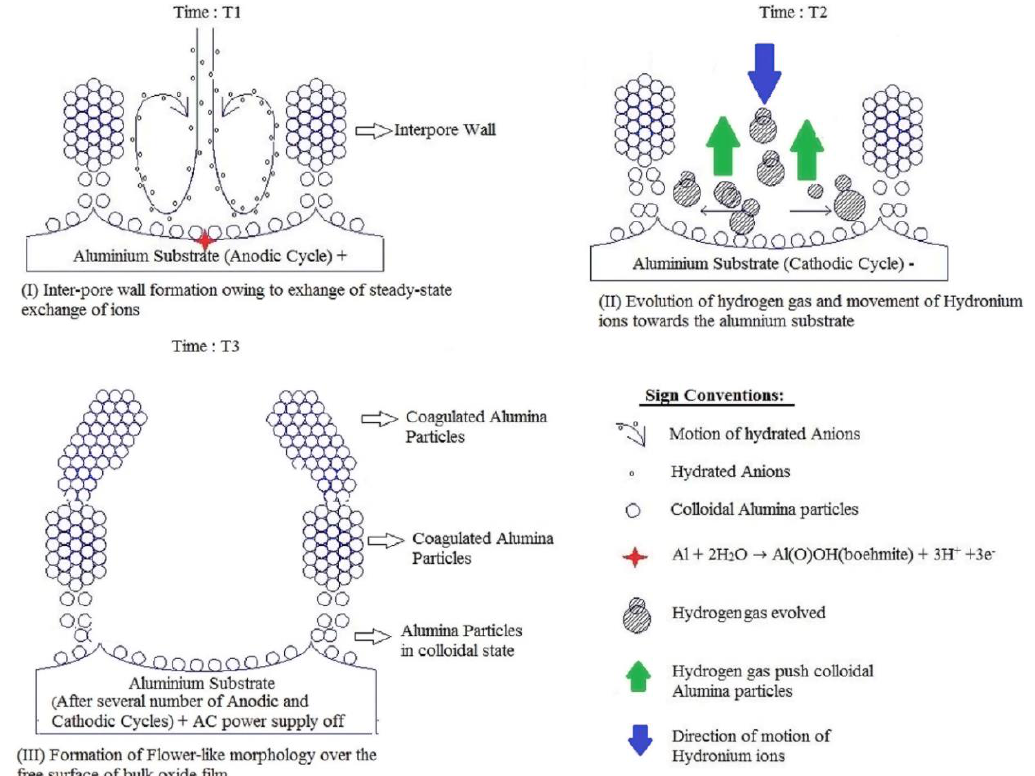
Figure 27. An extended model proposed by Chelliah et al. (based on the existing theory of electroconvection-assisted PAA formation) in order to include consideration of the processes occurring during AC anodizing. The additional mechanisms were suggested to explain the formation of flower-like structures microscopically observed on the surface of AC-generated PAA laminas. Reproduced with permission from [149]. Copyright 2017 Elsevier.